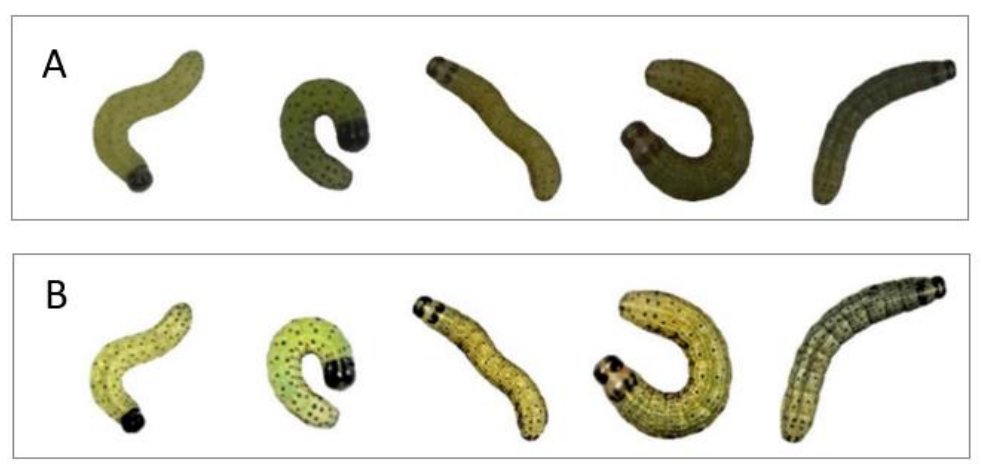
Figure 8. The enhancement effect of Retinex algorithm. ( A ) before enhancement; ( B ) after enhancement. Nine grayscale matrix statistic values (mean, entropy, contrast, correlation, autocorre- lation, homogeneity, and energy) are calculated, and the average value of the above four directions are taken as the texture feature for the grayscale combination to describe the grayscale relationship and spatial features between image pixels. The extraction effect of specific texture parameters is shown in Figure 9.